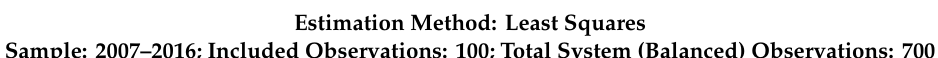
Table 6. Estimation Method: Least